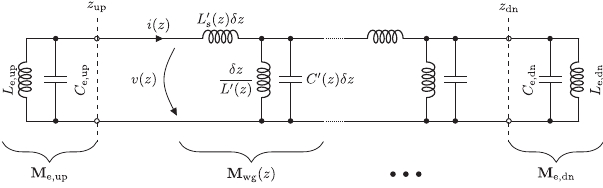
FIG. 17. Transmission line model of the symmetric four-vane RFQ cavity with ends, valid for both quadrupole and dipole